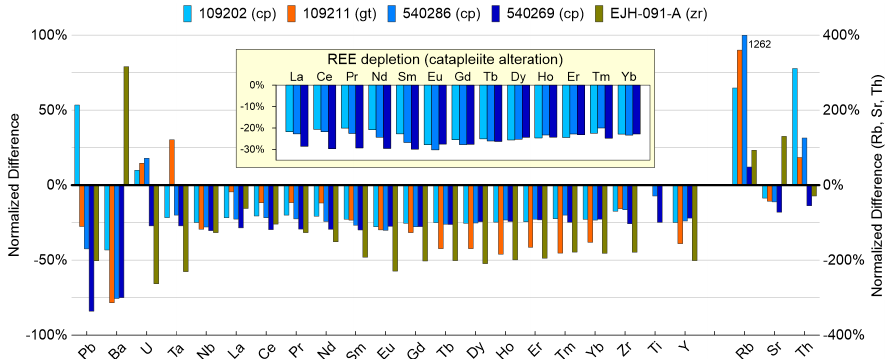
Figure 6. Relative differences in trace element concentrations between pseudomorphs and eudialyte, calculated for an element X as: ([X pmo ] − [X eud ])/[X eud ] × 100%. Sample EJH/12/091 contains no fresh eudialyte for comparison and was compared to the average eudialyte concentration from this study ( n = 3, 109211 excluded from average). Note the different scale for Rb, Sr and